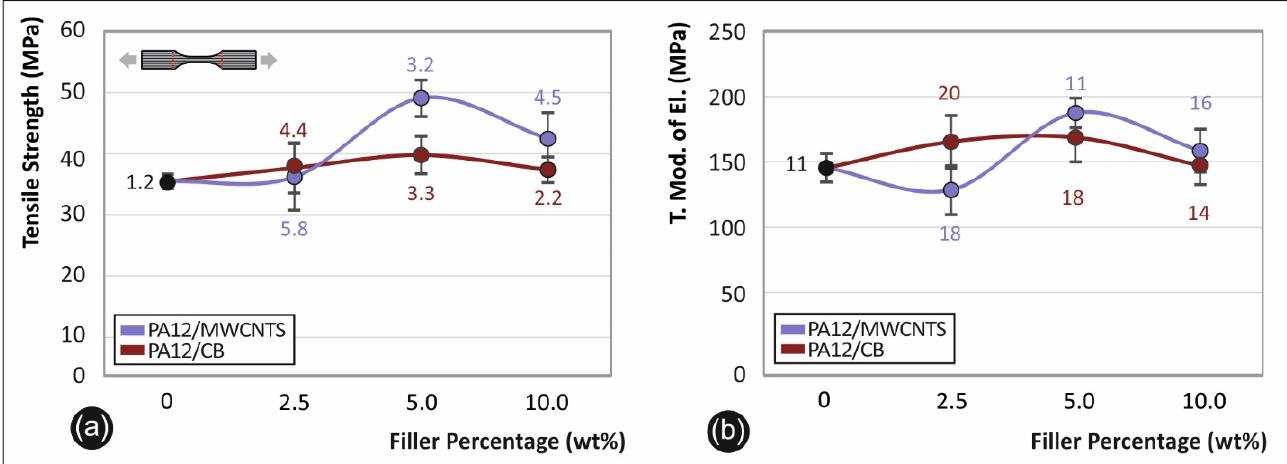
Figure 9. ( a ) Tensile strength average values along with the calculated standard deviation and ( b ) average tensile modulus of elasticity values; both as a function of the different filler loadings for the PA12/MWCNT and PA12/CB nanocomposites, respectively.